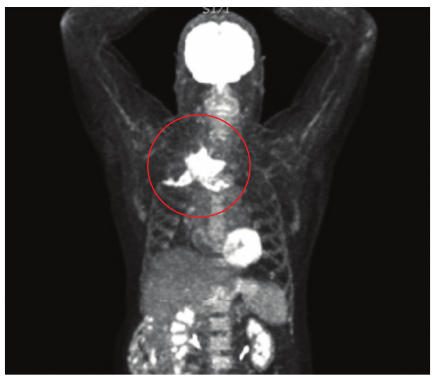
Figure 2: Patient 2. PET-CT frontal view, with reaction in the right sternoclavicular joint.